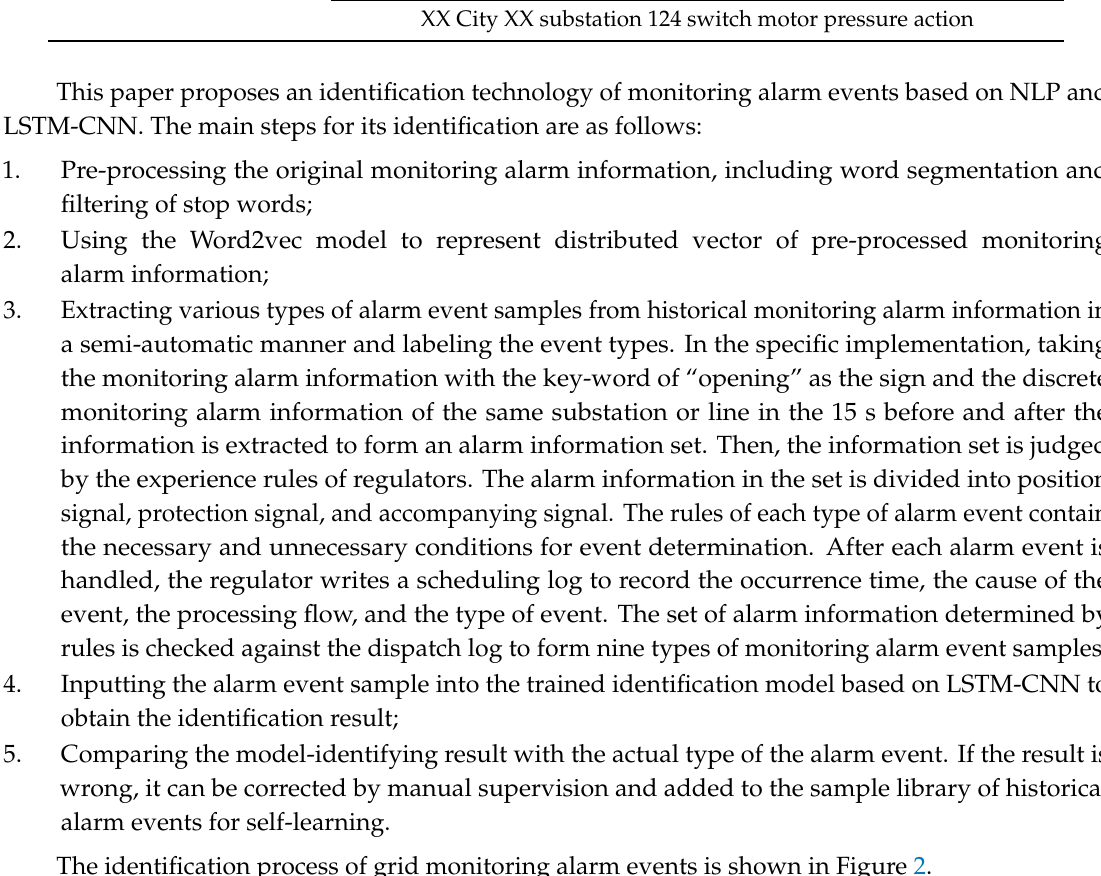
Table 1. Example of an alarm event sample.